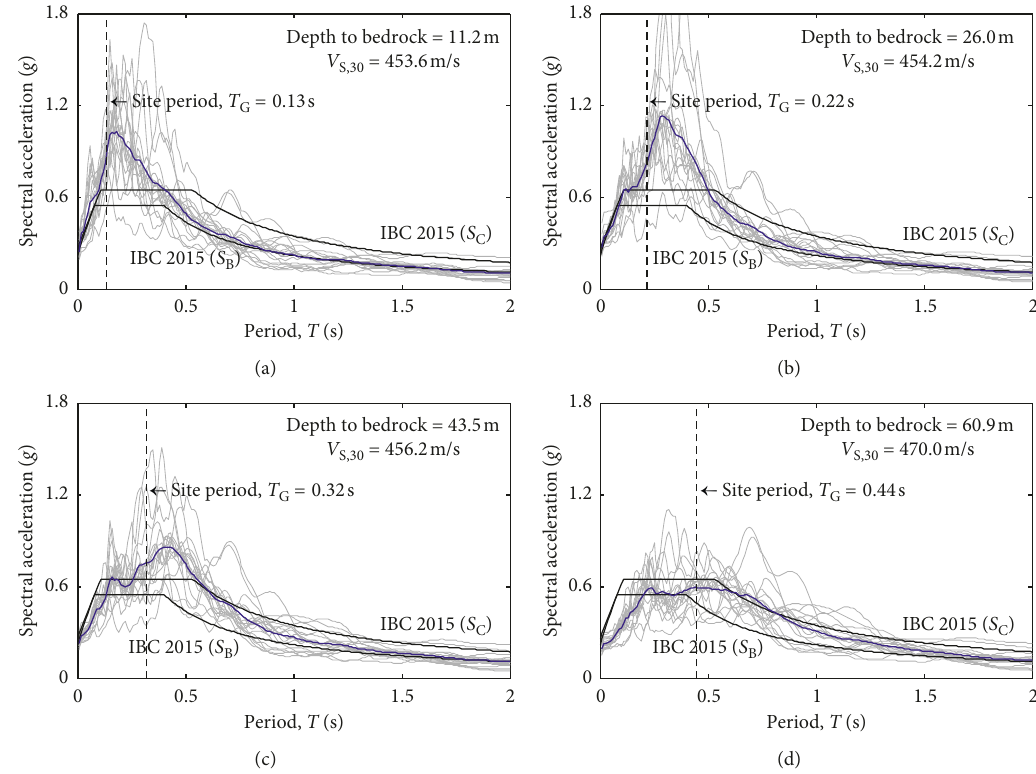
Figure 9: Responsespectrumresultingfromnumerical analysisoffour S C siteswithdepthto